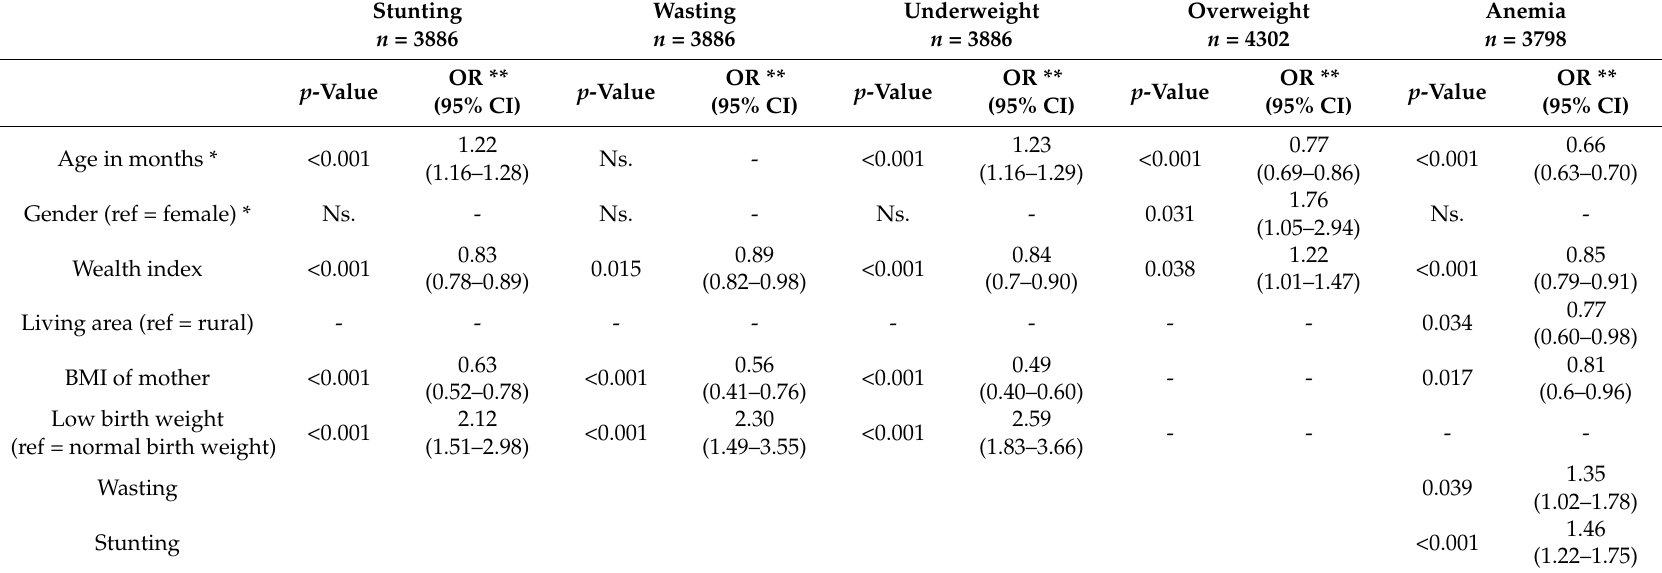
Table 7. p -values and odds ratio of contributing factors to stunting, wasting, overweight, and anemia in the 2014 DHS